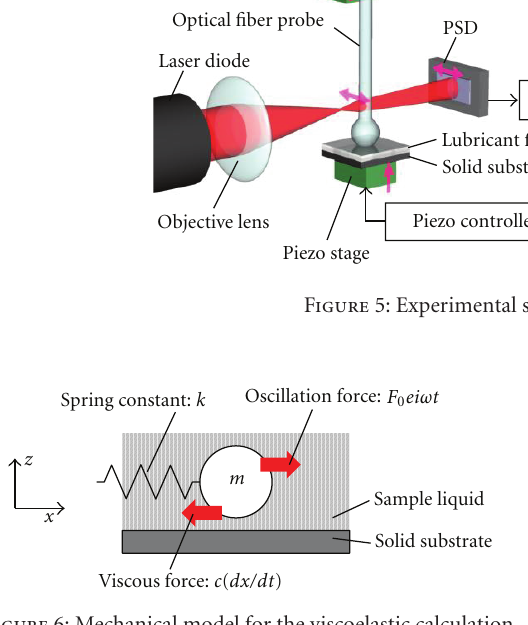
Figure 6: Mechanical model for the viscoelastic